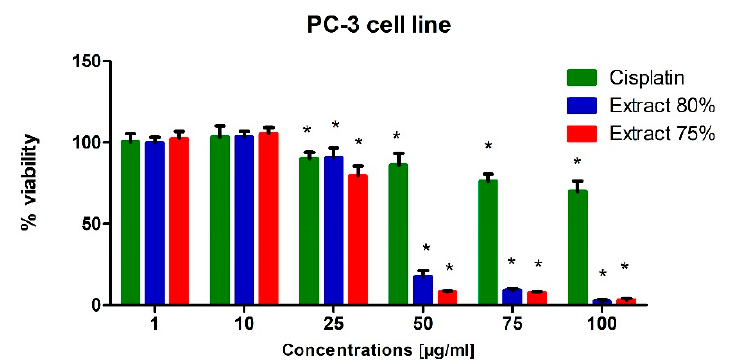
Figure 1. Viability of the PC-3 cell line (%) after 24 h of incubation with various concentrations of extract at 80%, extract at 75% and Cisplatin used as reference compound, measured with MTT test; Significant values (*) compared with Cisplatin with p < 0.05 (one-way ANOVA with Tukey’s post hoc test).